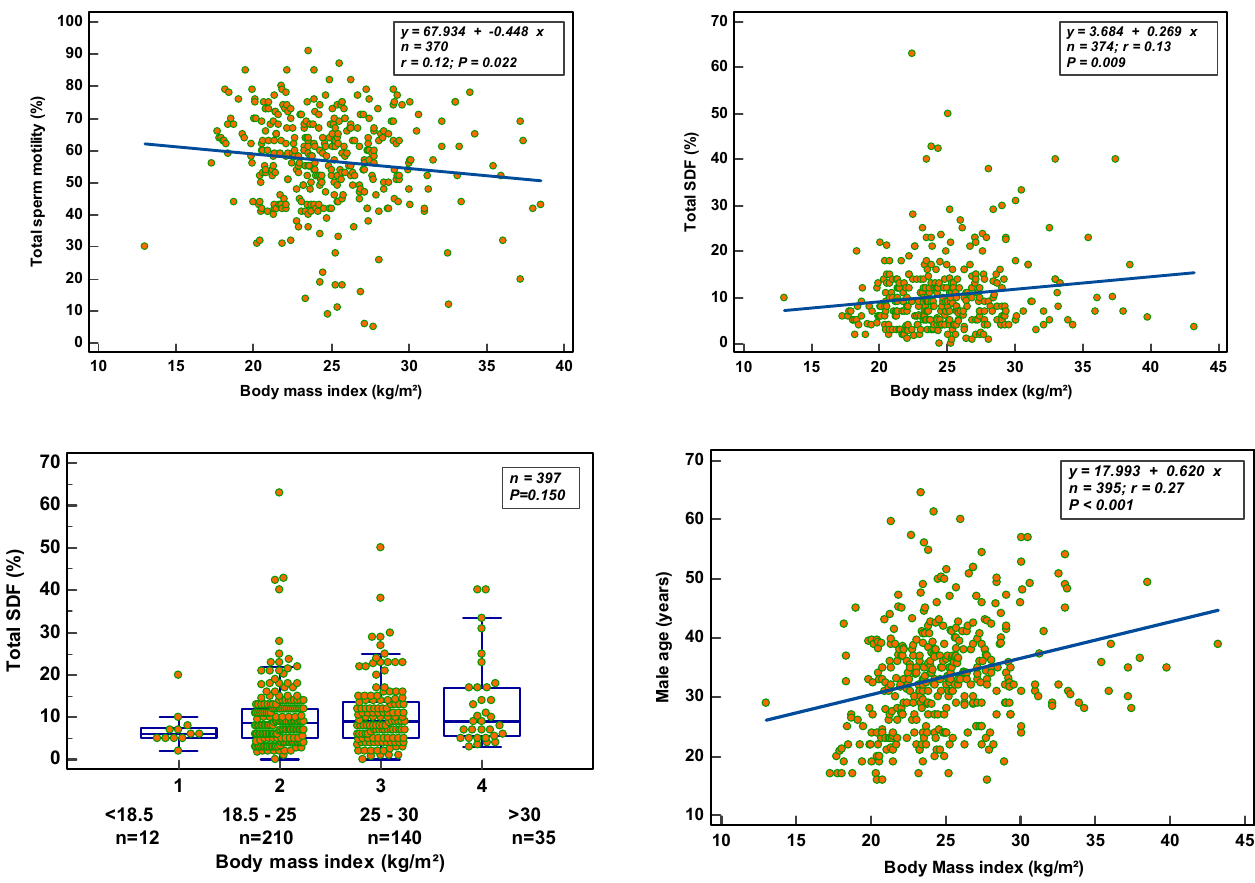
Figure 3. BMI-related effect on semen parameters, total SDF and age.